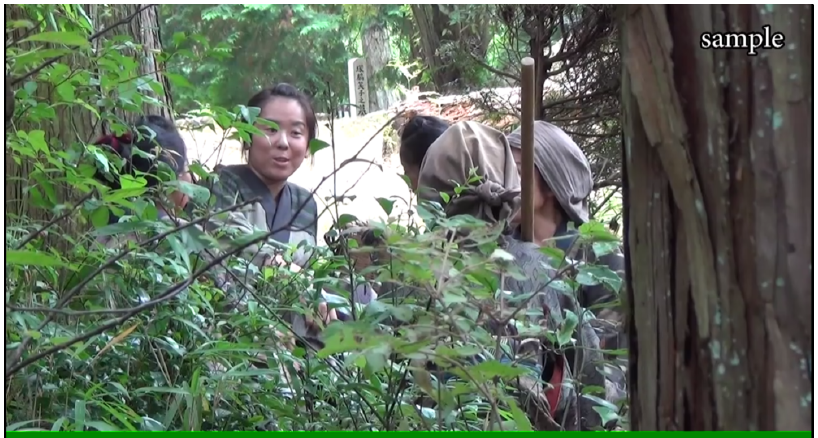
Fig. 8. A voyeuristic view of Yasukawa. After Gamushara